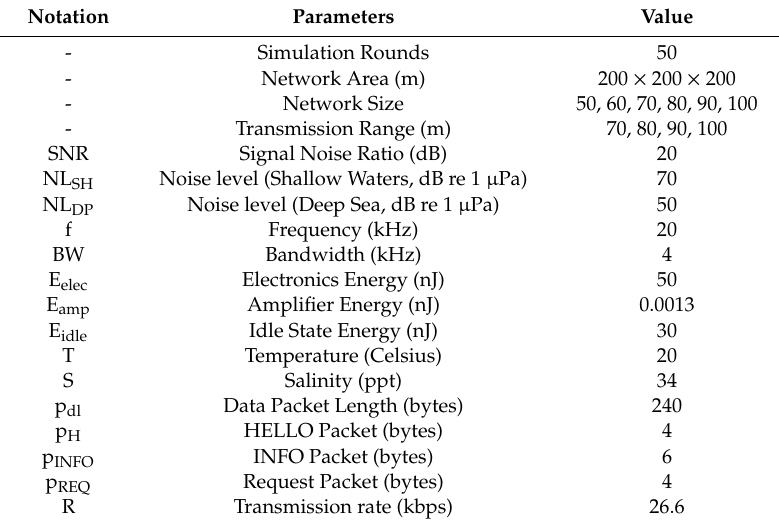
Table 1. Simulation